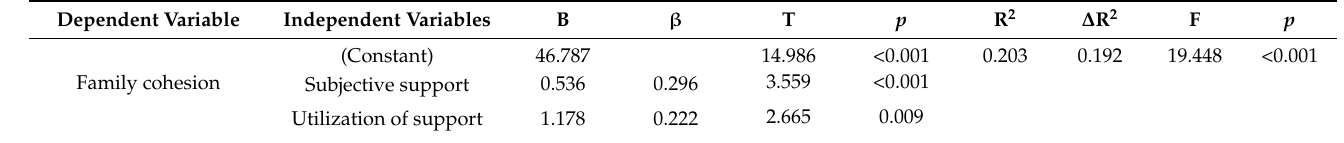
Table 3. Multiple regression analysis for social support predicting family